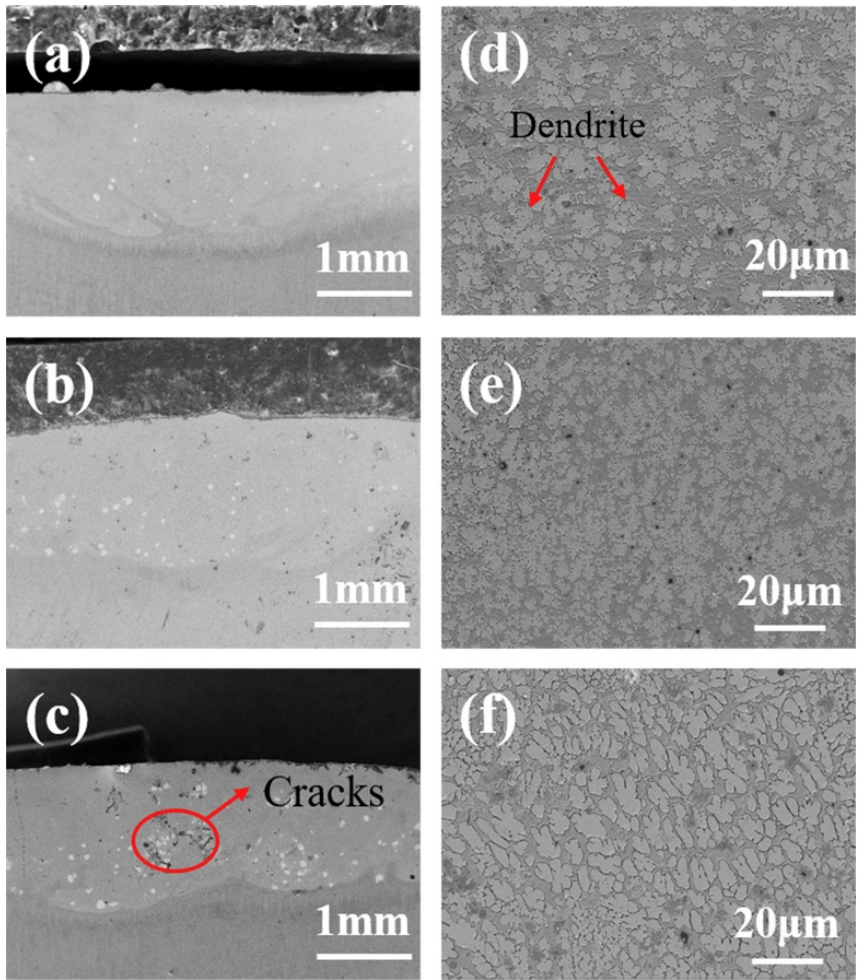
Figure 4. SEM images: ( a – c ) entire morphology of HEA coatings fabricated by laser cladding with laser power of 3 kW and scanning rate ranging from 3 to 5 mm/s; ( d – f ) microstructure of middle regions in HEA coatings fabricated by laser cladding with laser power of 3 kW and scanning rate ranging from 3 to 5 mm/s. (Reprinted with permission from ref. [44]. Copyright 2018 Elsevier). The quality of laser cladding HEA coating is not just affected by laser power and scanning speed; other parameters are also critical to obtain good quality HEA